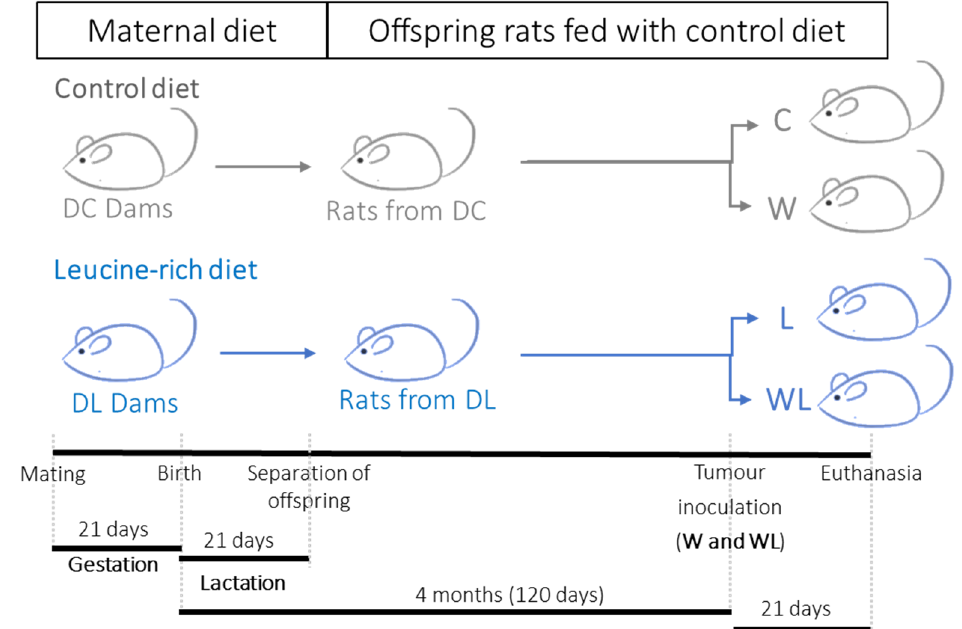
Figure 1. Schematic diagram of the experimental procedure. Legend: DC, dams fed control diet during gestation and lactation periods; DL, dams fed leucine-rich diet during gestation and lactation periods. Adult o ff spring were distributed into C, Control; W, Tumour-bearing animals; L, Group without tumour with a maternal leucine-rich diet; and WL, Tumour-bearing group with a maternal leucine-rich diet. For details, see the Materials and Methods section. DC (n = 3), DL (n = 3), and the final number of adult o ff spring rats (C, W, L, and WL) was 7–8 per group.